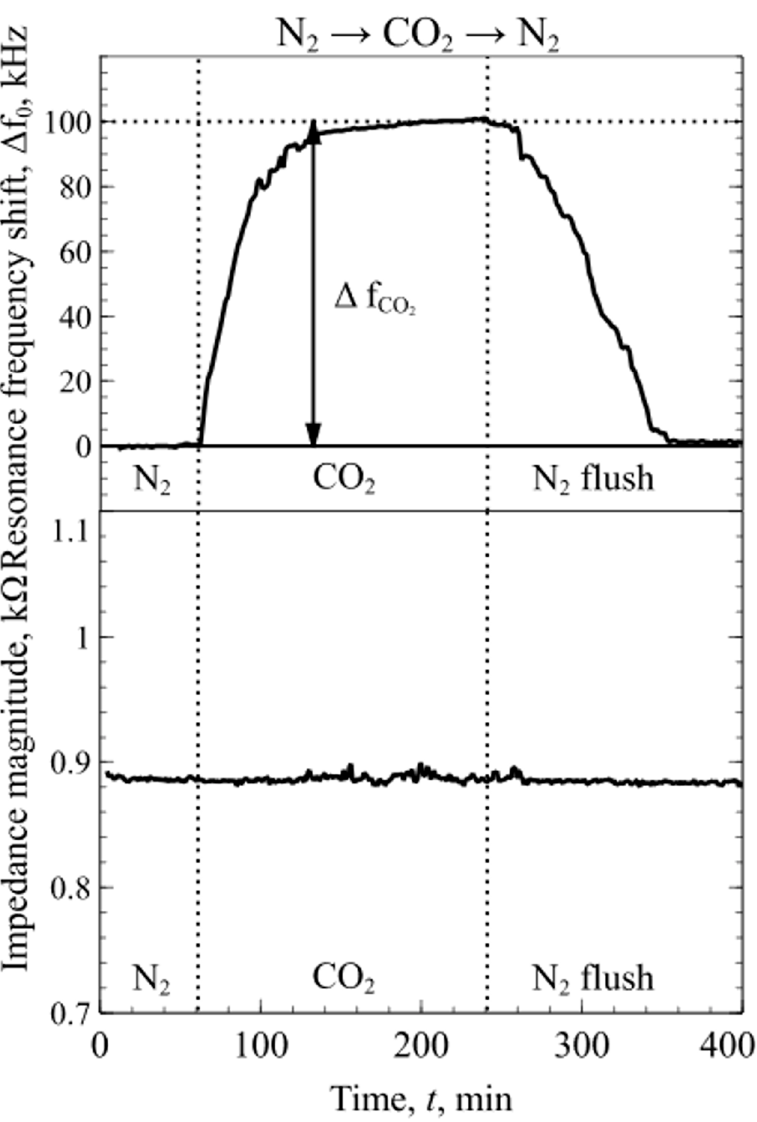
Figure 6. Continuous resonance frequency shift and magnitude of the impedance spectra as a function of time when transitioning between N 2 and CO 2 .